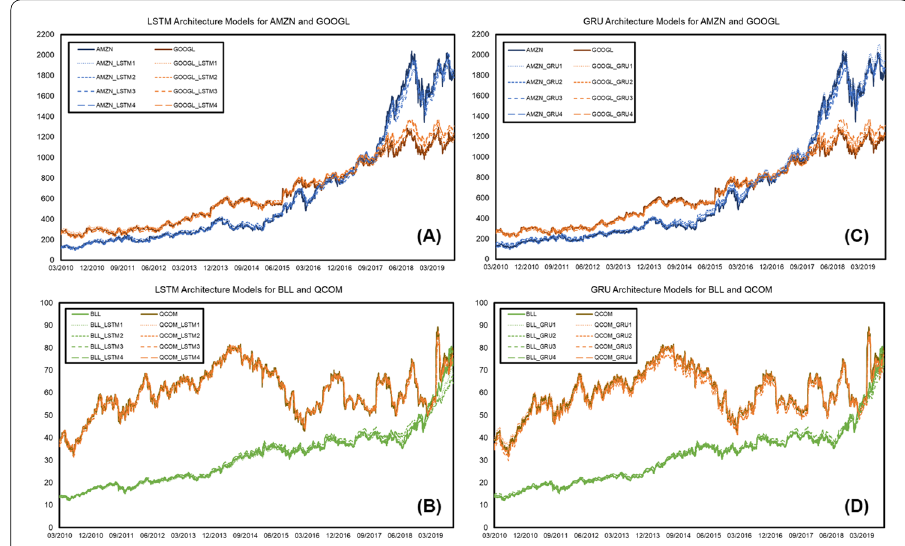
Fig. 11 Trained LSTM and GRU architectural models of four companies